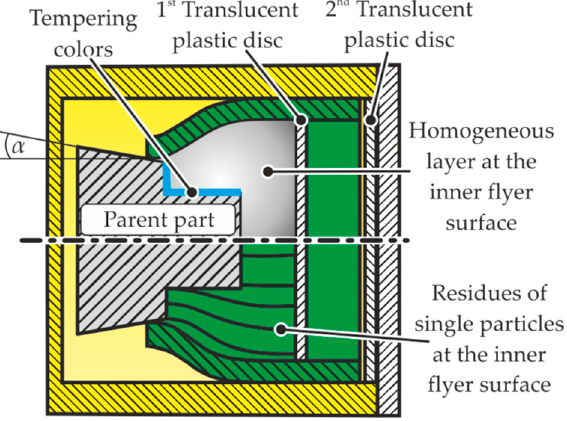
Figure 11. Effects on the flyer and parent surface (position of all parts is fixed during MPW).